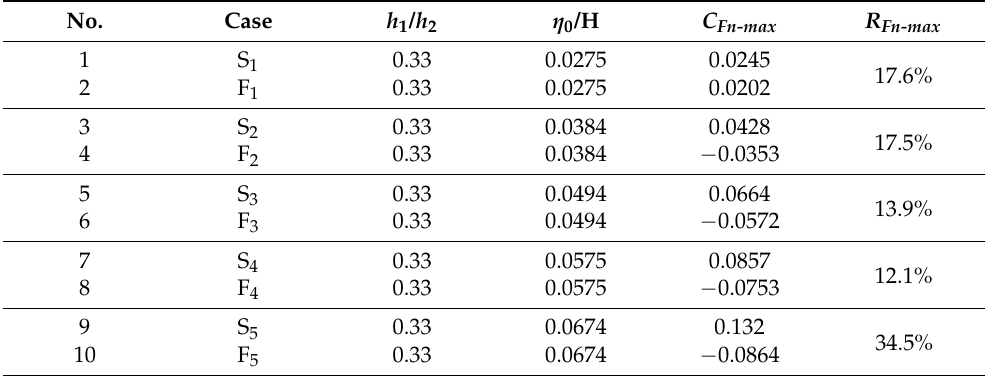
Table 3. Case introduction for different